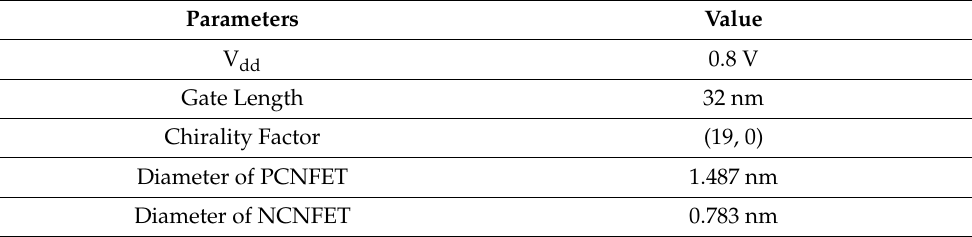
Table 2. Parameters of